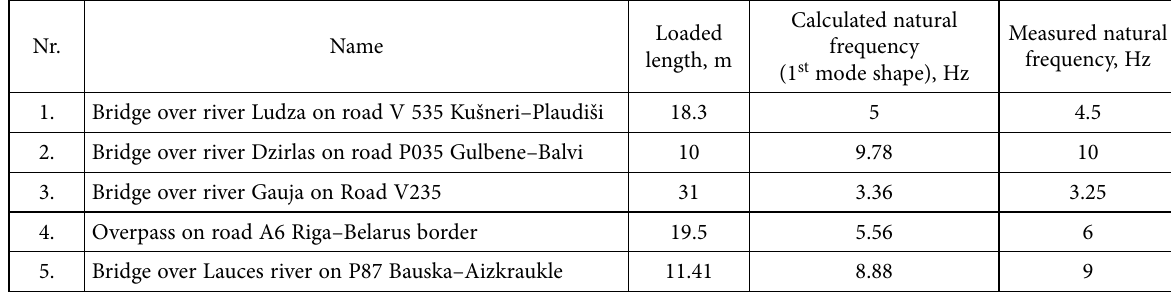
Fig. 15. Cross section and first mode shape of an overpass on Fig. 16. Cross section and first mode shape of a bridge over road A6 Riga–Belarus border. FE model constructed Lauce river on P87 Bauska–Aizkraukle. FE model constructed as a plate-strut 3D system as a plate-strut 3D system Table 2. Characteristic values of slab bridges